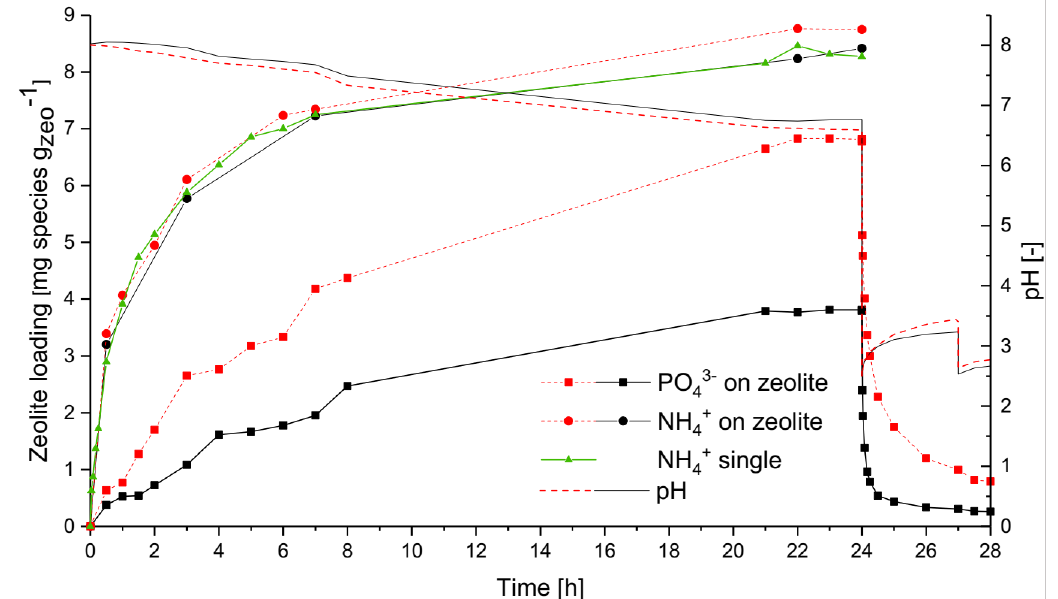
Figure 3. Effect of initial phosphate concentration at pH = 8 on P-removal. Initial values of experiments: black solid lines—257 mg NH 4+ L − 1 . 126 mg PO 43 − L − 1 pH = 8.02; red dashed lines: 267 mg NH 4+ L − 1 . 245 mg PO 43 − L − 1 pH = 8.00; green solid line: 259 mg NH 4+ L − 1 (ammonium